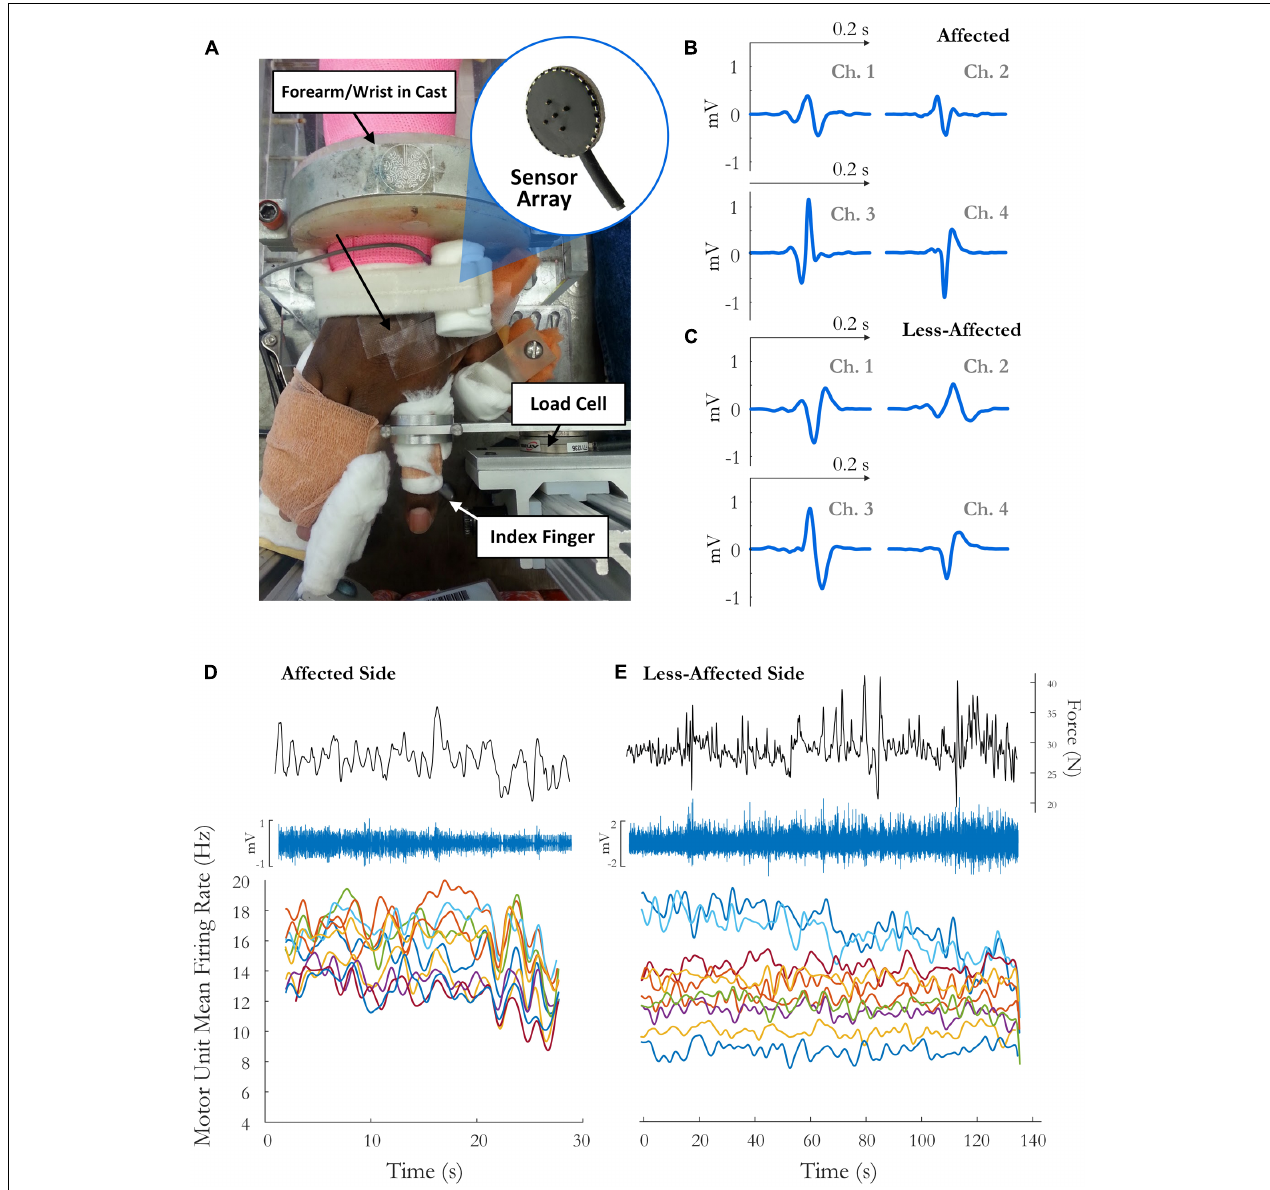
FIGURE 1 | (A) Experimental setup and sample motor unit (MU) action potentials (spike-triggered average) on each channel for the (B) affected side and (C) the less-affected side. The force trace, surface EMG signal (on the highest amplitude channel), and time-varying MFR of MUs over the fatiguing contraction on the (D) affected and (E) less-affected side in a single subject (obtained by low-pass filtering the impulse train with 2 and 5 s Hanning windows,